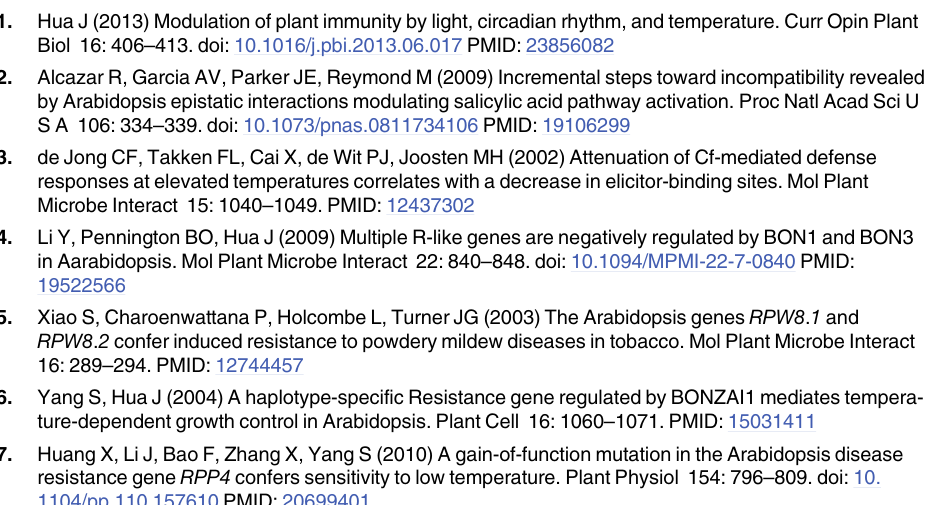
S8 Fig. chs3 ibr5 phenotype is not rescued by mpk12 mutant. (A) Diagram of genomic frag- ment of the MPK12 gene. The exons are presented as dark blue boxes, UTR regions are pre- sented as light blue boxes, and intron regions are presented as lines. The position of mpk12-3 (SAIL_543_F07) is shown. (B) RT-PCR analysis of MPK12 in Col and mpk12 . The EF1 α was used as a control. (C) Responses of MPK12-RNAi and mpk12-3 mutants to auxin. (D) Pheno-